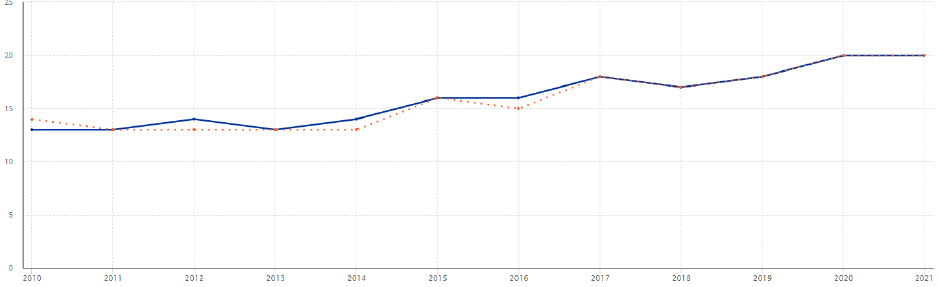
Figure 3. Share of enterprises’ turnover on e-commerce (as a percentage of the total number of or- ganizations).